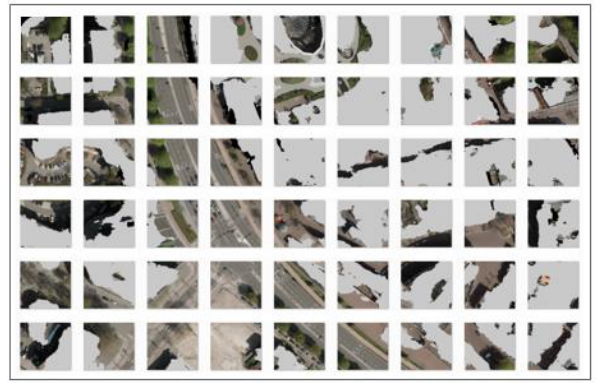
Figure 14. The building classification result